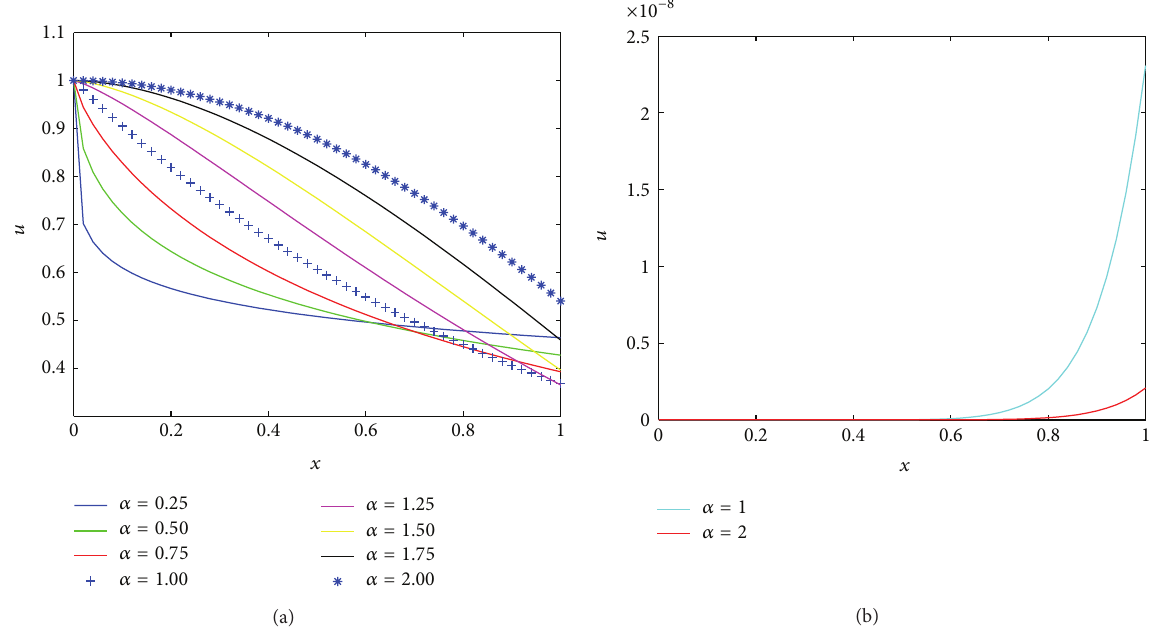
Figure 1: Numerical solutions and error for Example